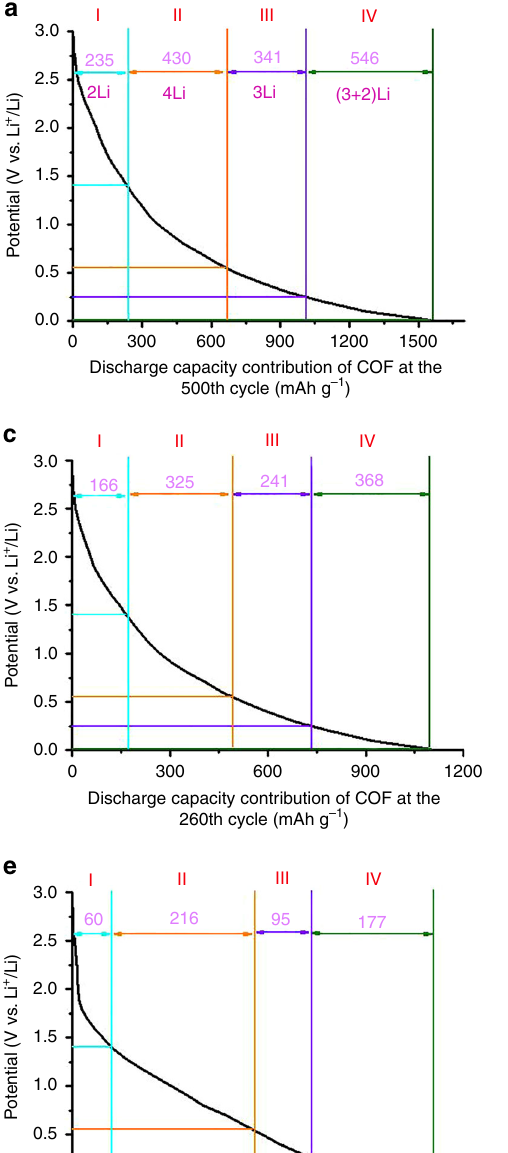
Elemental analysis . CHN elemental analysis was measured by Elementar Vario MICRO cube.